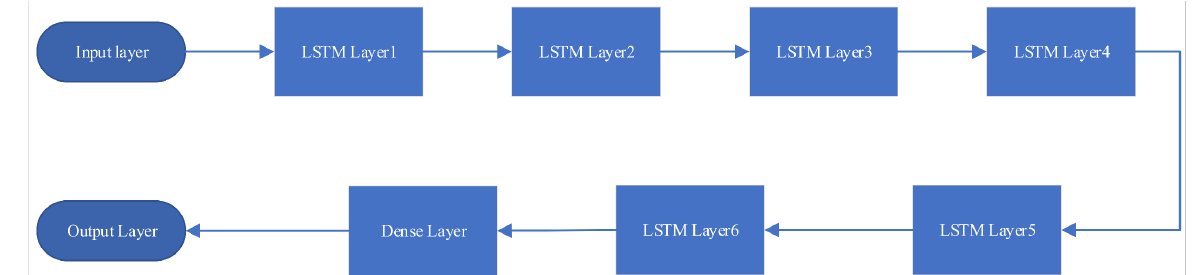
Figure 19. LSTM structure shows input layers, hidden layers, and output layers.